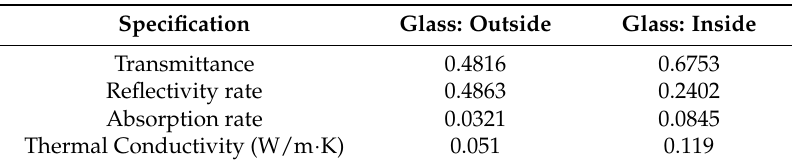
Table 12. Glass Properties of SDSW model.